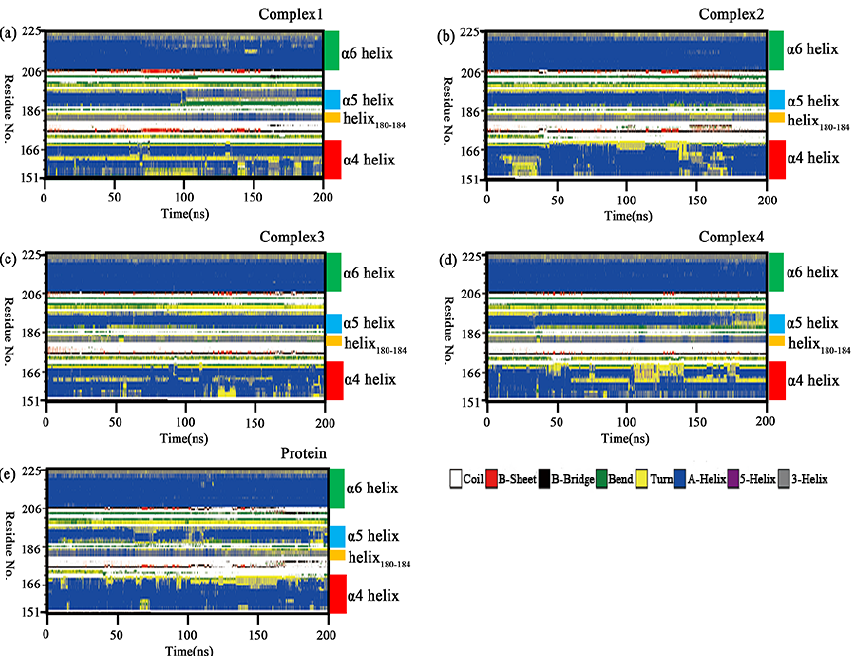
Figure 10. ( a – e ) Changes in the secondary structure of the lid domain (Ala151 – Pro225) in the complexes 1 – 4 and independent protein with simulation time.